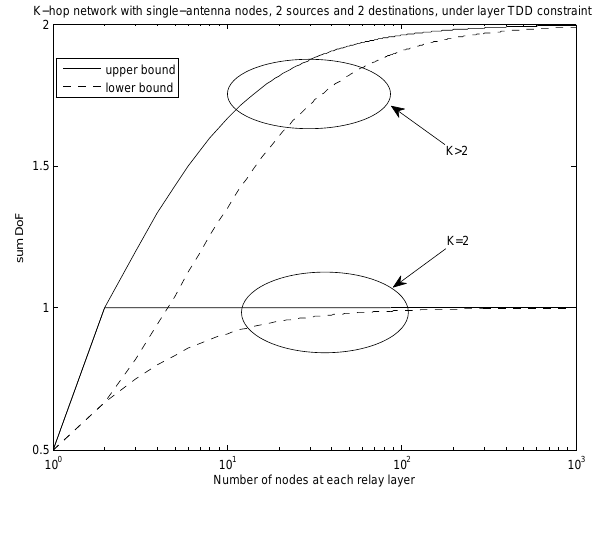
Figure 5. DoF property of directed multi-hop networks under layered TDD constraint